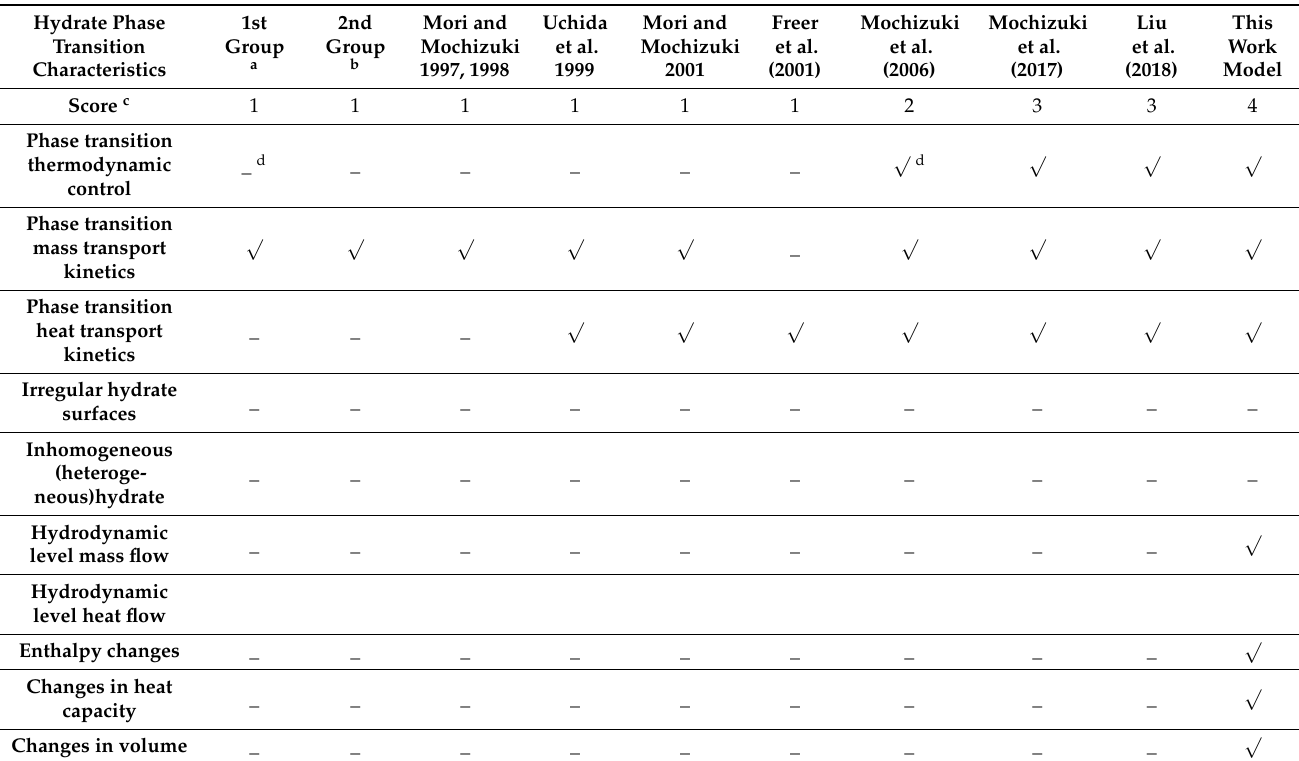
Table 1. Properties needed for hydrate kinetic modeling, including details missing in hydrate phase transition models proposed by various research